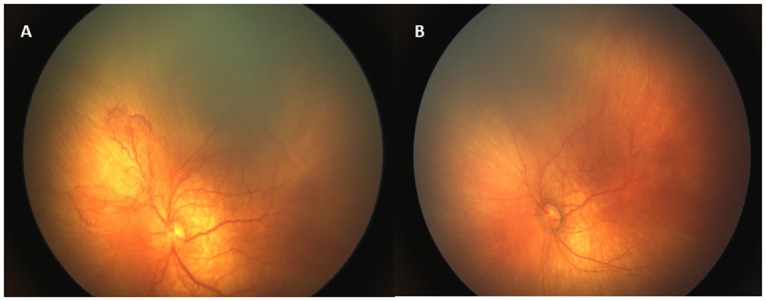
Retinal images of an infant with APROP (case no:29).(A) Intensive shunt vessels with plus disease indicate Zone I APROP. (B) A dramatic response to IVB injection with regression of plus disease and resolution of shunt vessels 1 week following treatment.